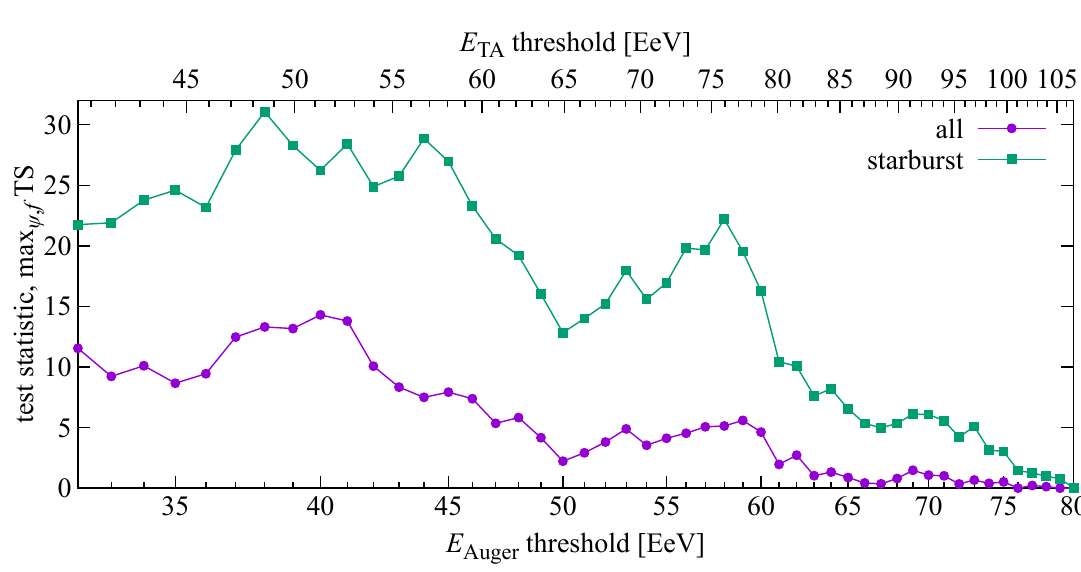
Figure 3. The TS as a function of the energy scale for the SBG catalogue (green) and the all-galaxies catalogue (violet).